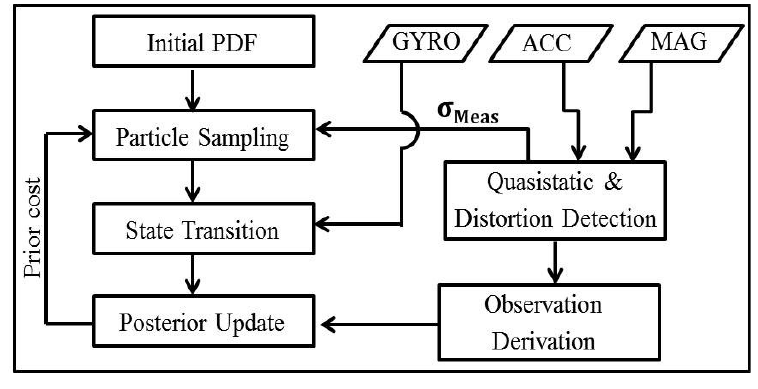
Figure 6. Overview of the particle filter approach used for orientation